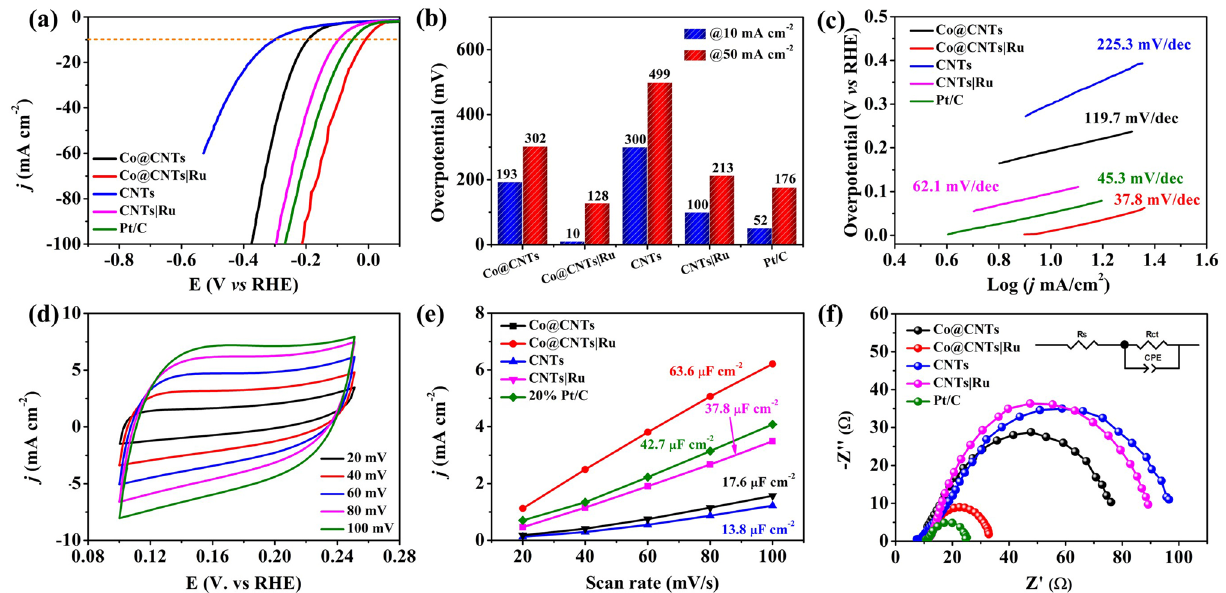
Fig. 3 a LSV curves, b overpotentials at a current density of 10 mA cm −2 , c Tafel plots of Co@CNTs, Co@CNTs|Ru, CNTs, CNTs|Ru and 20% Pt/C electrode; d CV curves for Co@CNTs|Ru electrocatalysts at different scan rates of 20, 40, 60, 80, and 100 mV s. −1 ; e C dl values and f corresponding EIS spectra of Co@CNTs, Co@CNTs|Ru, CNTs, CNTs|Ru and 20% Pt/C electrode in 1.0 M KOH solution (inset: the equivalent circuit for